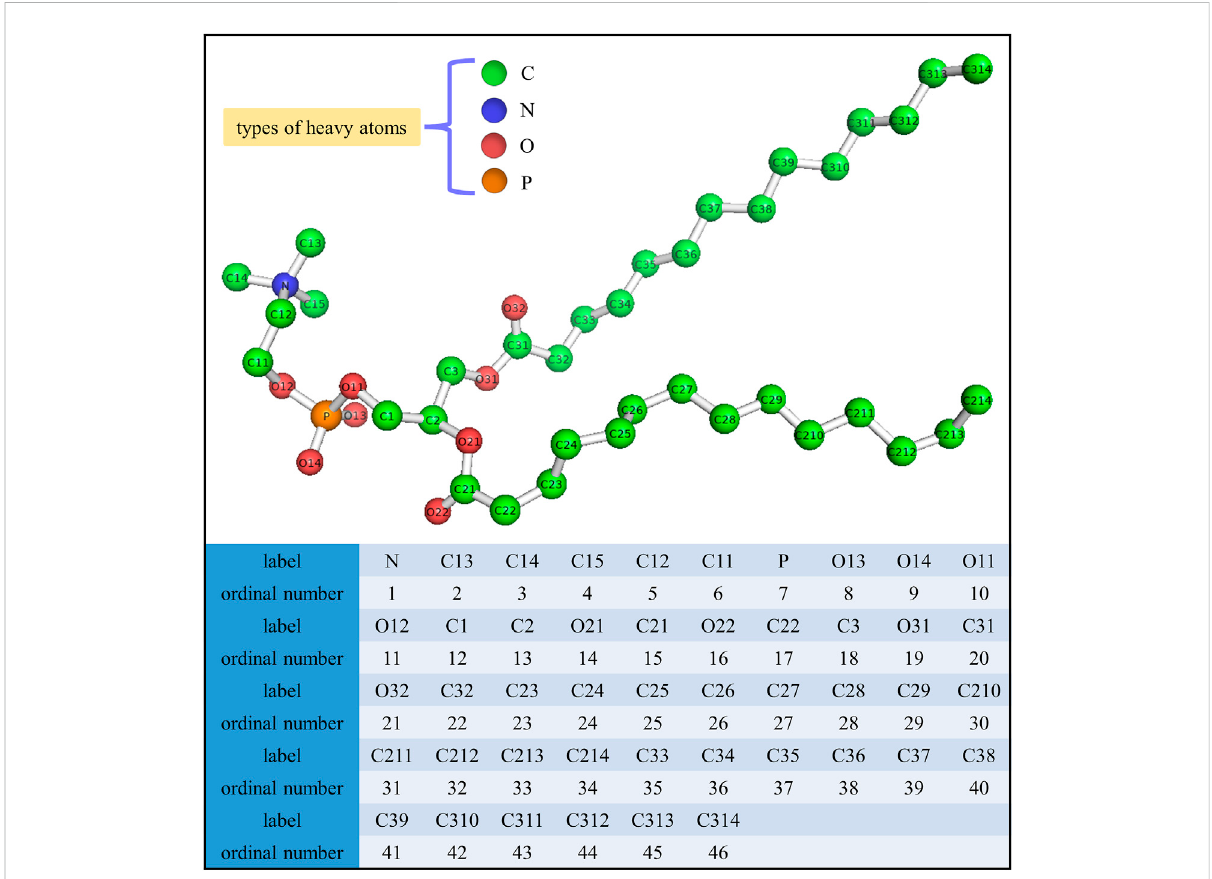
FIGURE 4 Label and the corresponding ordinal number for each heavy atom in a DMPC molecule.